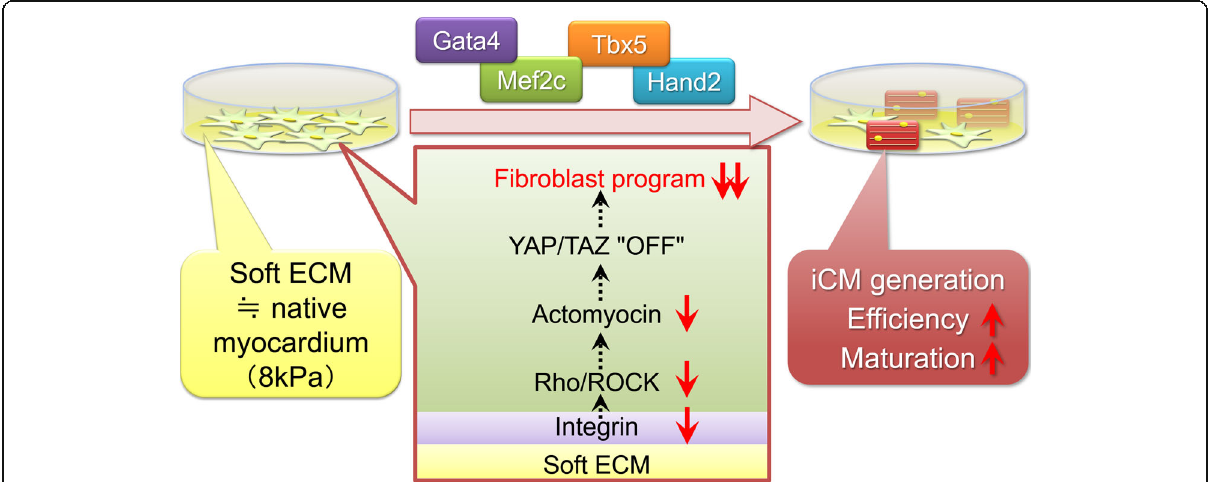
Fig. 4 Soft matrix promotes the efficiency and maturation of direct cardiac reprogramming [38]. Soft matrix enhanced cardiac reprogramming via YAP/TAZ suppression. As a result, this can increase the efficiency of induction and maturation of